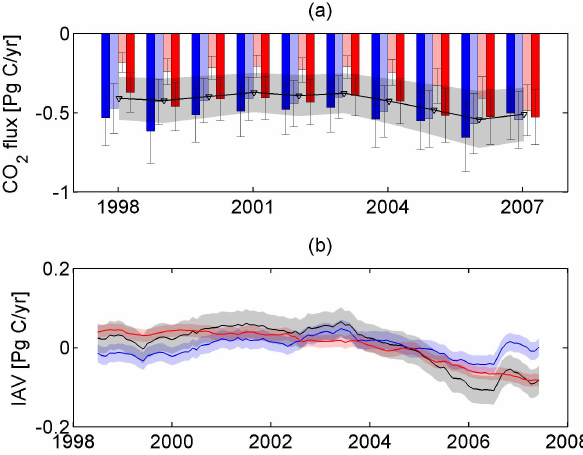
Fig. 12. (a) Seasonal and annual mean fluxes from 1998 to 2007 in the Atlantic Ocean (44 ◦ S–79 ◦ N and west of 30 ◦ E). Dark blue shows the results for the Northern Hemisphere winter months (DJF), light blue the spring months (MAM), light red the summer months (JJA), dark red the autumn months (SON). The annual mean flux is plotted as a black line on top. (b) Inter-annual variability (calculated using a 12month running mean) for the Northern Hemi- sphere (blue line), the Southern Hemisphere (red line) and the entire Atlantic Ocean (black